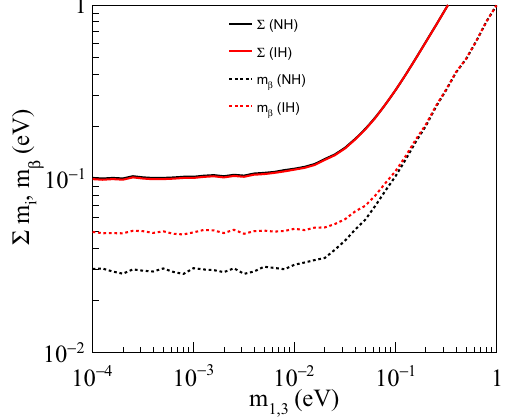
(cid:2) m i and m β with lightest neu-